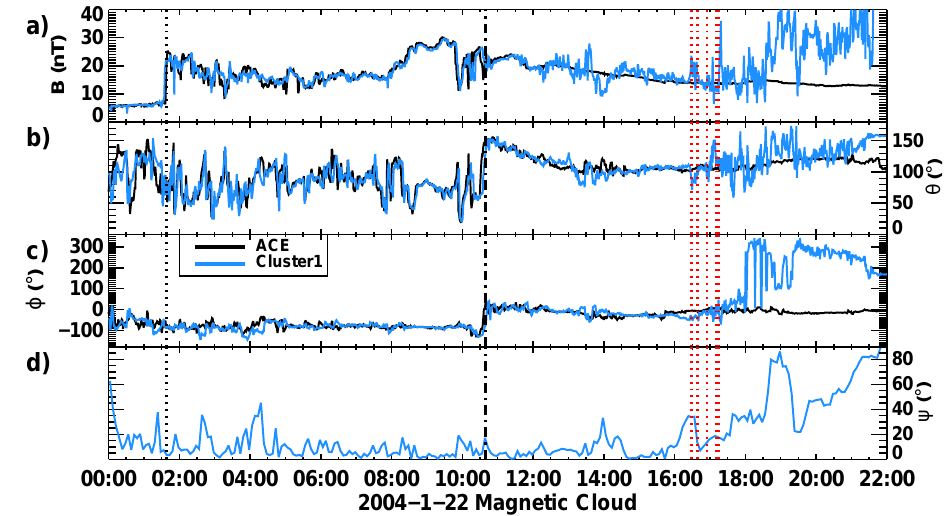
Figure 5. 22 January 2004 MC: observations from ACE (black) and Cluster (blue), in GSE coordinates. Same format as Fig. 3.